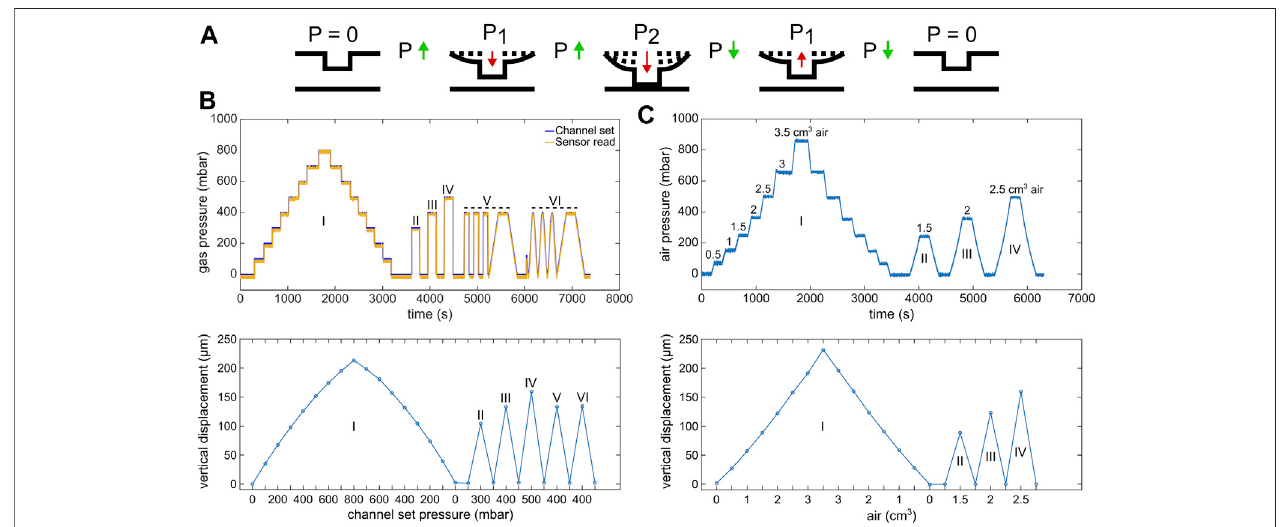
FIGURE3| Circularmicro-pistonactuationusingtwodifferentpressureapplicationsystems. (A) Schematicofmembranede fl ectionandmicro-pistonactuationby the applied pressure. At static state of the device, there was no external pressure ( p ), p (cid:2) 0. Vertical displacement of the membrane and micro-piston was measured, while the pressure was kept constant at p (cid:2) 0, P1 or P2. Membrane and micro-piston were actuated step-by-step by positive (increasing) pressure. Then, the applied pressure was decreased in the same manner step by step, and the displacement was measured at each decreased pressure for position recovery. Green arrows indicate when the pressure increased or decreased in between the states. Red arrows indicate the direction membrane and micro-piston moved. (B) Micro-piston actuation with various pressure magnitudes and loading pro fi les (I – VI) for the 215-µm membrane attached to 300-µm-diameter piston, generated by the pressure controller system. In pro fi le “ I, ” the pressures were positively or negatively applied step by step by 100 mbar increments, and the displacement was scanned at each step. In pro fi les “ II, ” “ III, ” and “ IV, ” the pressures were applied suddenly and the displacement was scanned for each sudden pressure amount. In pro fi les “ V ” and “ VI, ” cycliccompressionwherethemembranewasde fl ectedandretractedrepeatedlywasappliedbyanautomatedpressureapplicationwith(V)orwithout(VI)timeintervals. On the pressure pro fi le graph, “ channel set ” is the pressure that was set through the pressure controller of the system, while the “ sensor read ” is the pressure that was read through the pressure sensor connected to the gas fl ow into the control channel of the micro-piston device. (C) Micro-piston actuation with various air amounts leading to corresponding pressure magnitudes in the pro fi les I-IV for 215 µm membrane attached to 300-µm-diameter piston, generated by a syringe pumping system. In pro fi le “ I, ” the pressures were positively or negatively applied step-by-step by 0.5 cm 3 increments in air amount. The resulting pressures were read through the pressuresensorsandthedisplacementwasscannedateachstep.Inpro fi les “ II, ”“ III, ” and “ IV, ” thepressureswereappliedsuddenlyandthedisplacementwasscanned for each sudden pressure